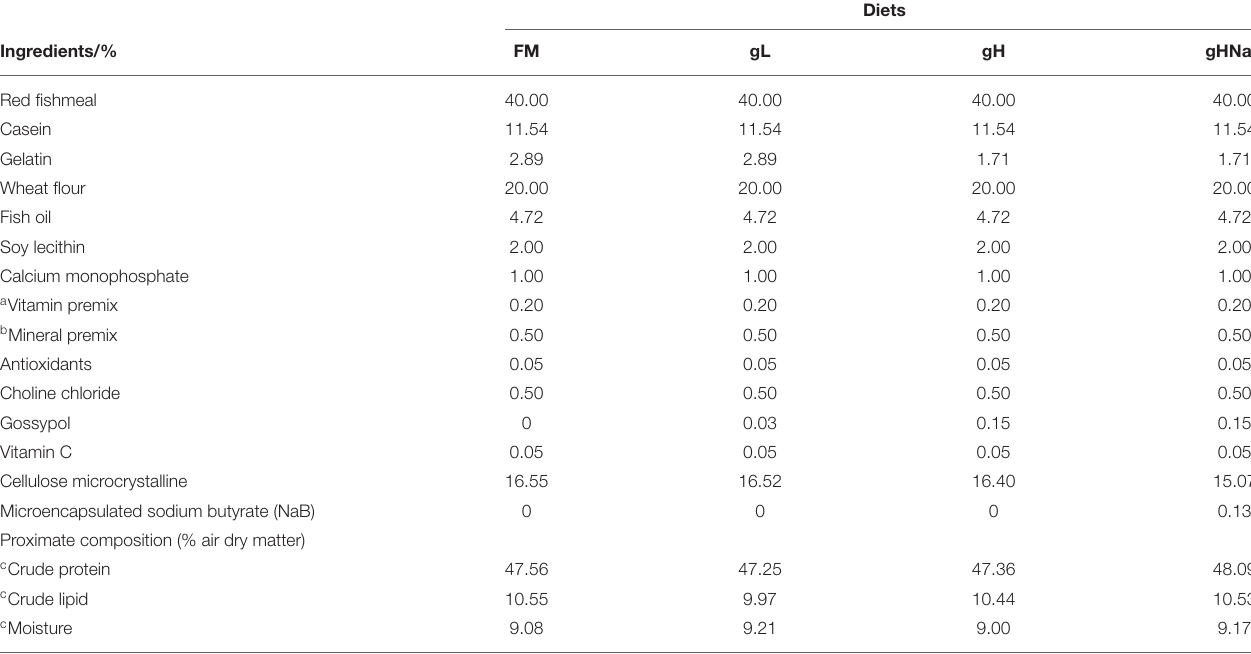
TABLE 1 | Formulations and proximate composition of the experimental